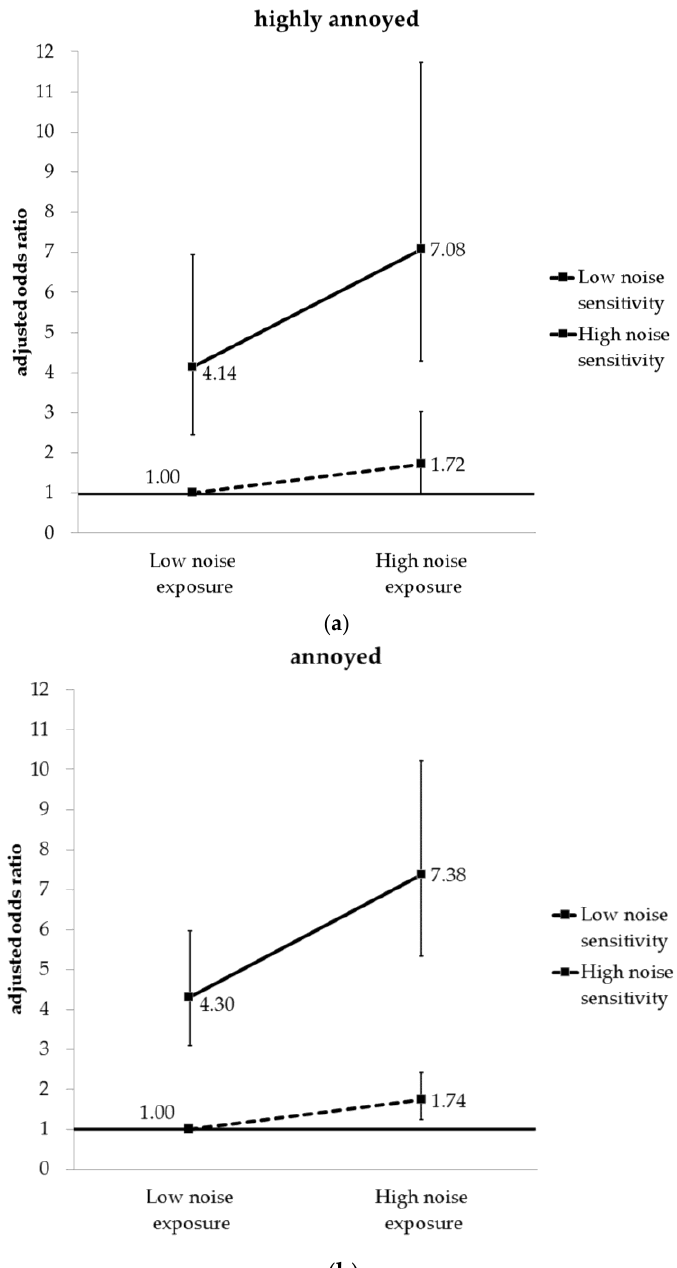
Figure 2. Adjusted odds ratio of being ( a ) “highly annoyed” and ( b ) “annoyed” according to noise sensitivity and noise exposure.